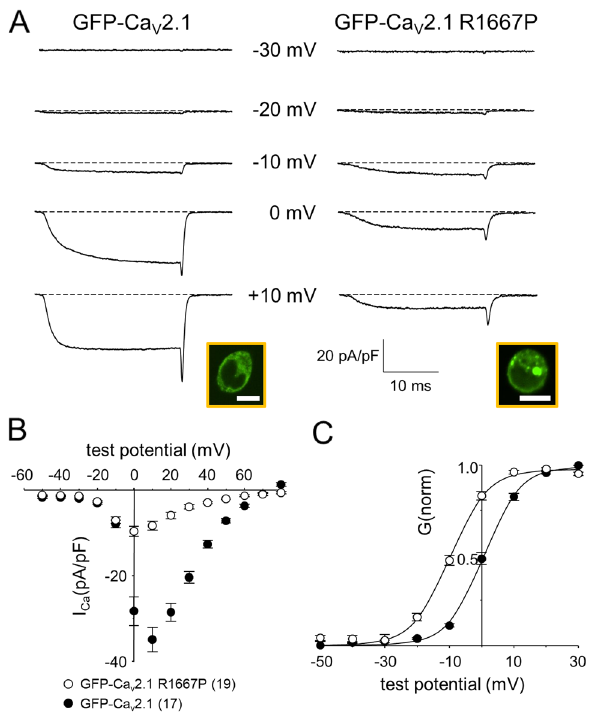
Figure 2. The R1667P mutation causes a profound reduction in Ca 2+ current density and a hyperpolarizing shift in Ca V 2.1 activation. ( a ) Ca 2+ current families recorded from tsA-201 cells expressing GFP-Ca V 2.1 ( left ) or GFP-Ca V 2.1 R1667P ( right ) with auxiliary β 4 and α 2 δ-1 subunits. Currents were elicited by a 25 ms step depolarizations from − 80 mV to indicated test potentials; the repolarization voltage was − 40 mV. Confocal images confirming successful heterologous expression of GFP-Ca V 2.1 and GFP-Ca V 2.1 R1667P are shown in the insets . Scale bars = 10 µm. ( b ) Comparison of GFP-Ca V 2.1 (filled circle; n = 17) and GFP-Ca V 2.1 R1667P (open circle; n = 19) average peak I–V relationships. Currents were evoked at 0.1 Hz by test potentials ranging from − 50 mV through + 80 mV in 10 mV increments. Amplitudes were normalized by capacitance (pA/pF). ( c ) Normalized G–V curves were fit by Eq. (1) with the following respective parameters for GFP-Ca V 2.1 and GFP-